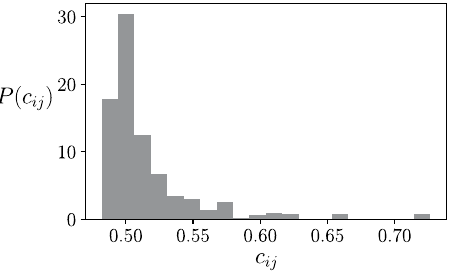
Figure 1. Distribution of correlation values used for learning, generated from a 20 × 20 lattice Ising model at critical